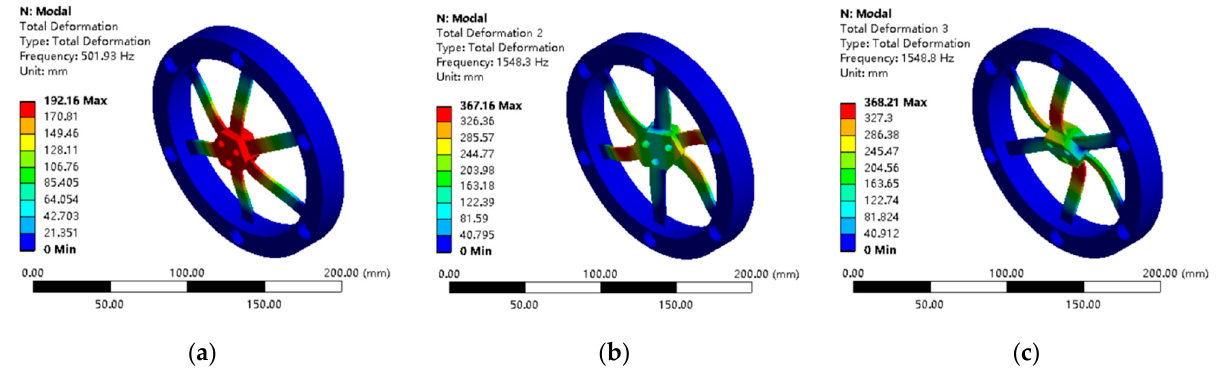
Figure 5. The first three mode shapes of the CEE without load: ( a ) the first mode; ( b ) the second mode; and ( c ) the third mode.